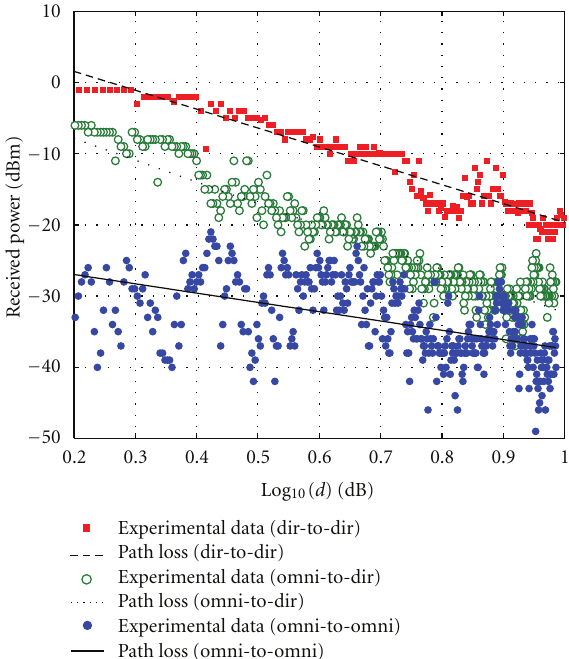
Figure 13: Impact of antenna angle in reducing small-scale fading.